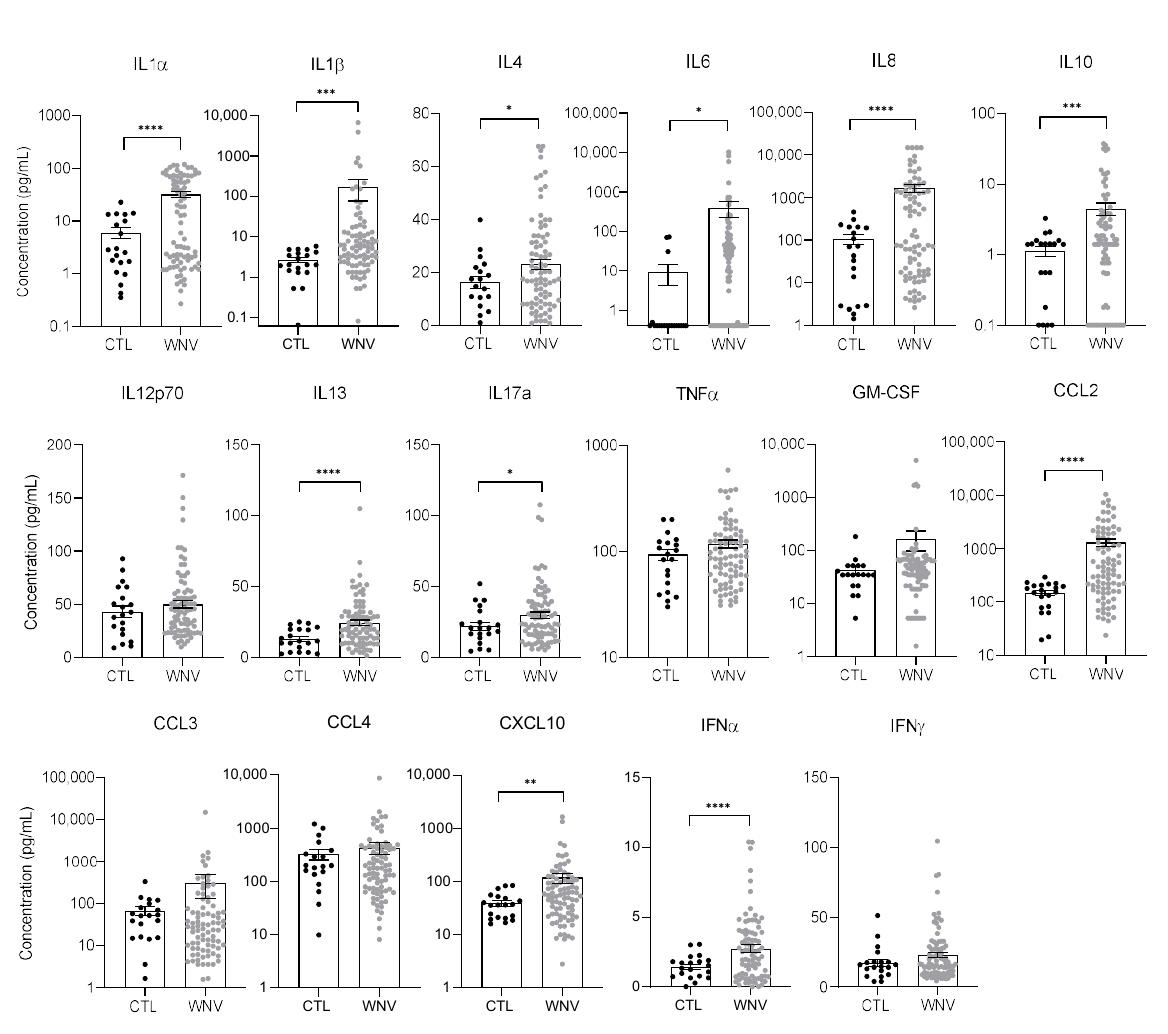
Figure A1. Biomarkers of inflammation in WNV-patients compared to healthy individuals. Plasma concentration in pg/mL of different pro-inflammatory markers of non-infected (black) and WNV- infected (grey) humans, measured by multiplex bead-based ELISA. Bars show means ± SEM (* p < 0.05, ** p < 0.01, *** p < 0.001, **** p < 0.0001).